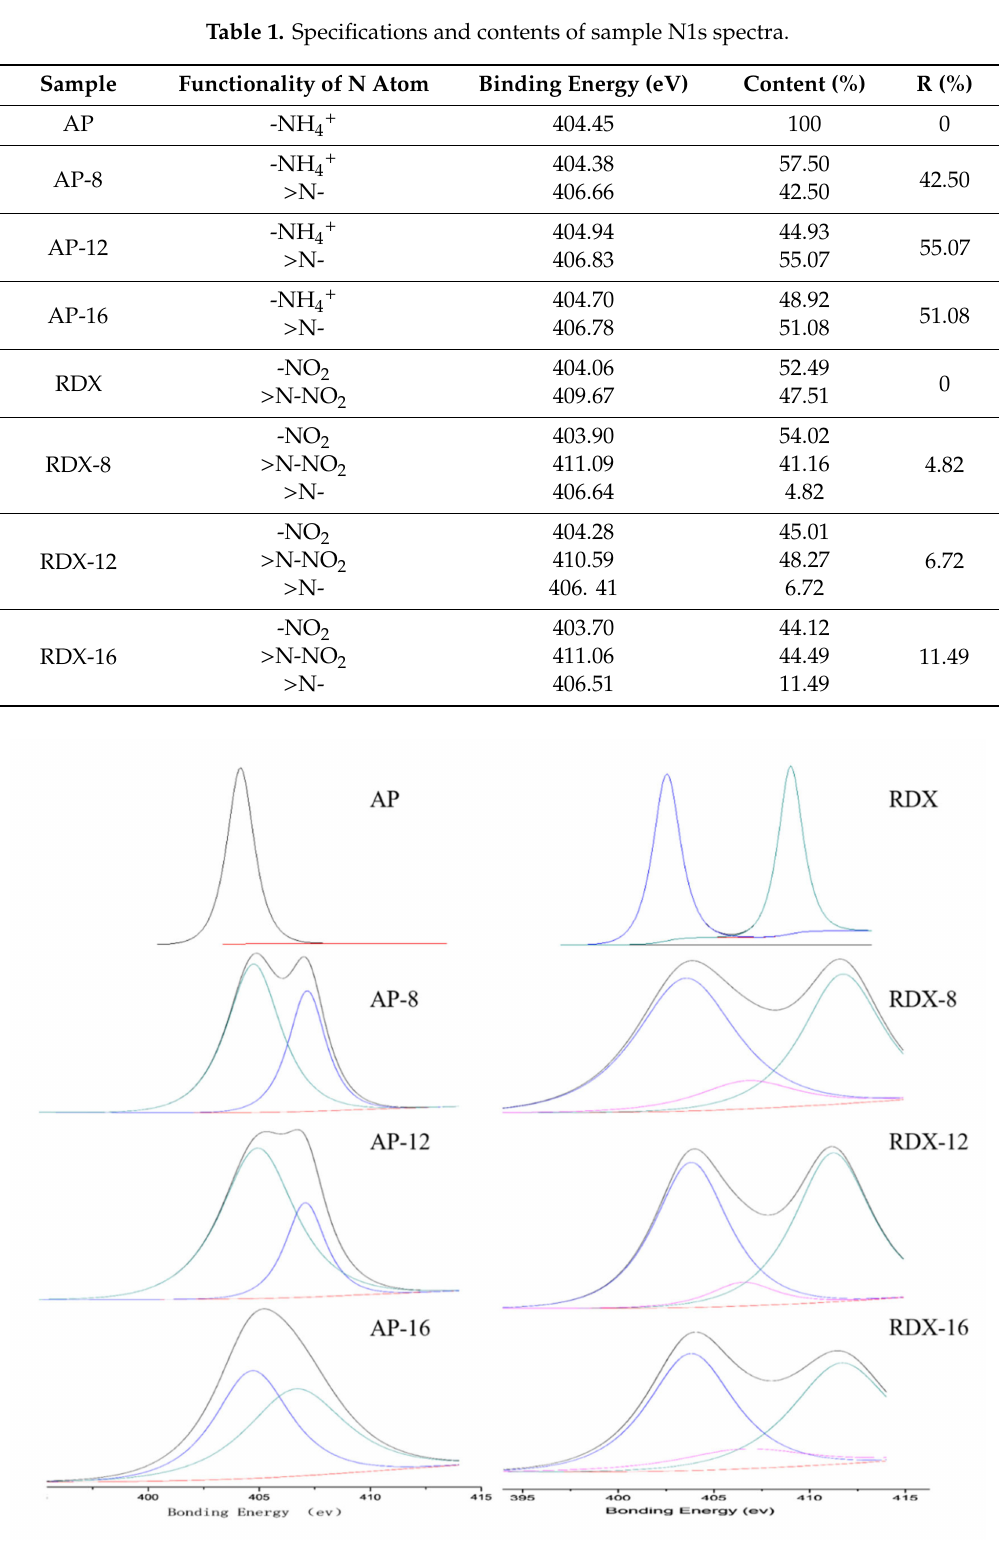
Figure 5. Fitting curves of the XPS N1s spectra of pure AP and RDX solid particles and the particles coated with bonding